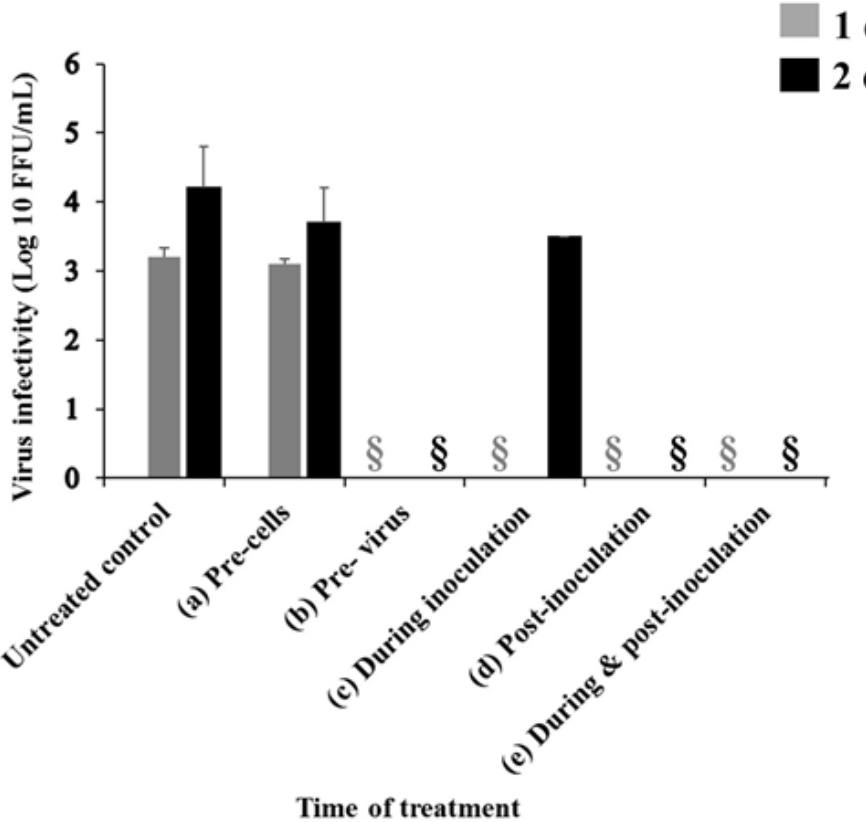
Figure 2. Effect of the addition of WV at various time points during HCV infection. Huh7it-1 cells and/or HCV were treated with WV (500 ng/mL) at various time points and HCV production in the culture was determined. (a-e) Quantity of HCV particles in the supernatants. The intracellular virus in each set experiment was quantified 48 hours after infection by analyzing focus forming units per milliliters (FFU/mL). Data obtained from two independent experiments and represented as means ± SEM. §: below the detection